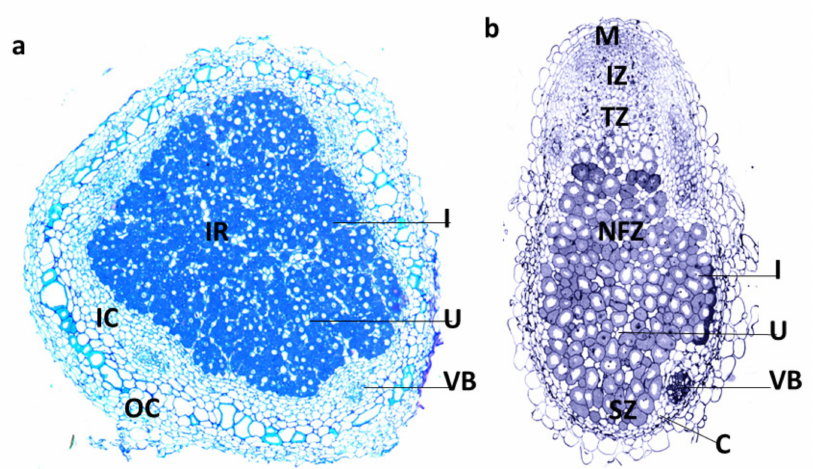
Figure 1. Structure of determinate ( a ) and indeterminate ( b ) nodules. a. Section of a determinate nodule from soybean. Determinate nodules do not have a persistent meristem. The central infected zone contains large infected cells (I) containing symbiosomes and smaller uninfected cells (U). This region is surrounded by the cortex including the inner cortex (IC) with vascular bundles (VB) and the outer cortex (OC). ( b ). Section of an indeterminate M. truncatula nodule. The nodule has a persistent meristem (M, often termed zone I) and continues to grow producing zones of different developmental stages including the infection zone (IZ, zone II), transition zone (TZ, interzone II-III), nitrogen fixation zone (FZ, zone IV) and senescence zone (SZ, zone V). The nitrogen fixation zone contains both infected cells (I) and uninfected cells. Vascular bundles (VB) are present in the nodule cortex (C). Images courtesy of Aleksandr